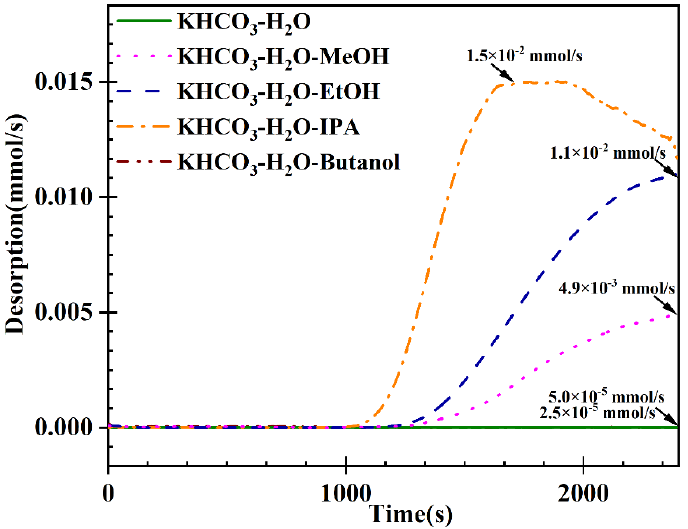
Figure 4. CO 2 desorption rates in KHCO 3 − H 2 O and KHCO 3 − H 2 O − alcohol solutions.